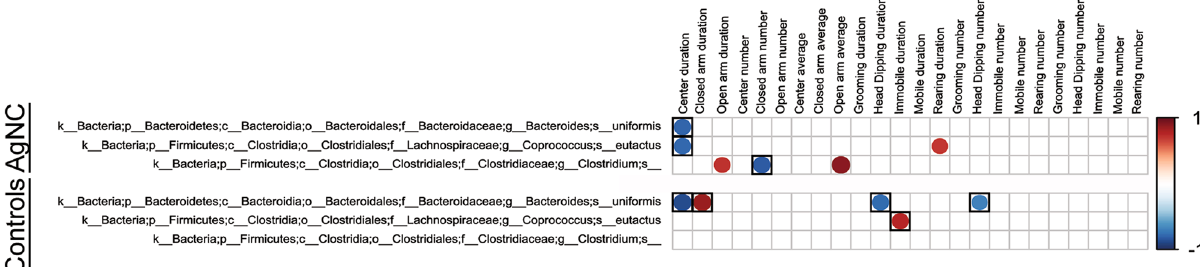
Figure 13. Correlations of fecal microbiota changes and EPM results in AgNC and control groups. This figure correlates the bacterial changes identified with LEfSe (Fig. 8) and the EPM results (Fig. 5). The correlations and data presented as detailed in Fig. 9. However, the values without a box only showed a statistical trend (P ≤ 0.1 for significance), whereas those with a black box were significant (P ≤ 0.05).